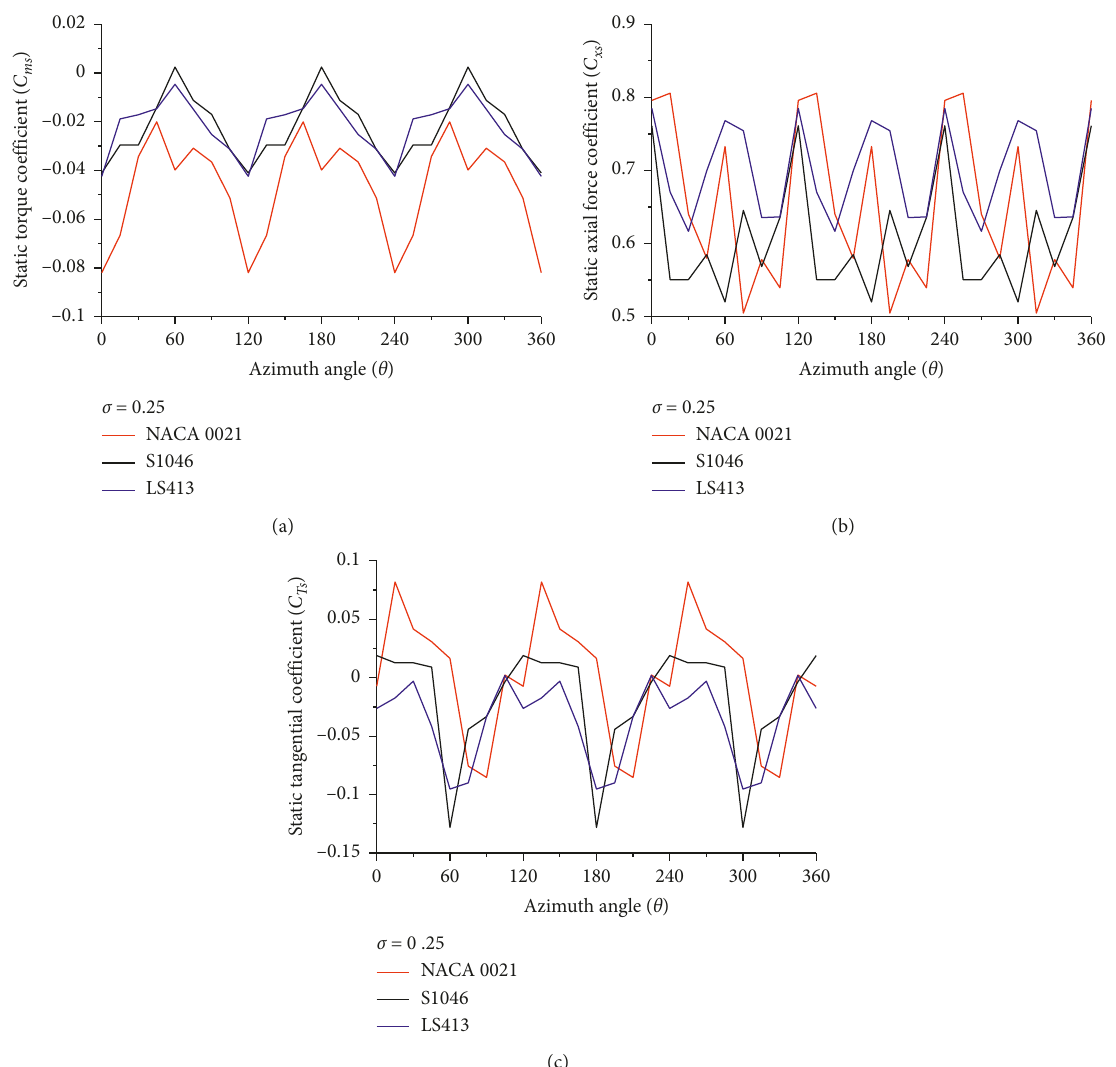
Figure 11: Static torque, static axial force, and static tangential force coefficient on the Darrieus turbine.